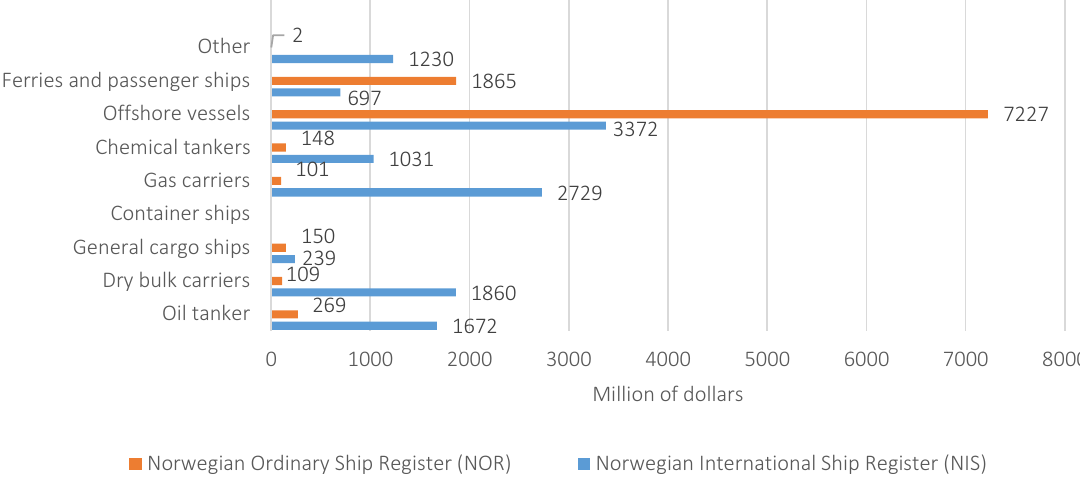
Figure 1. Norwegian fleet by flag of registration and the value of the ship type, 2018